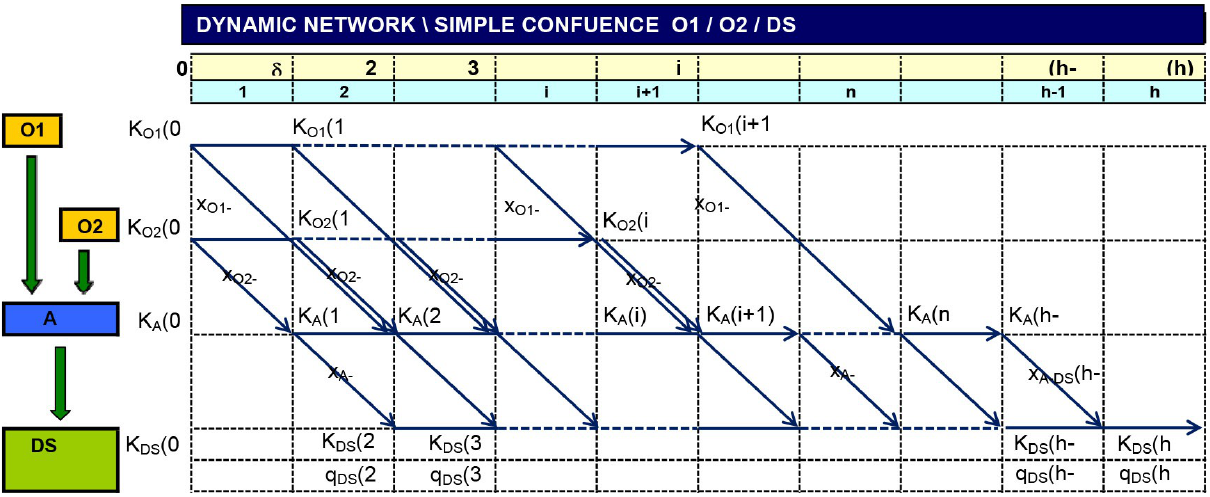
Figure 15. Values of a simple confluence dynamic